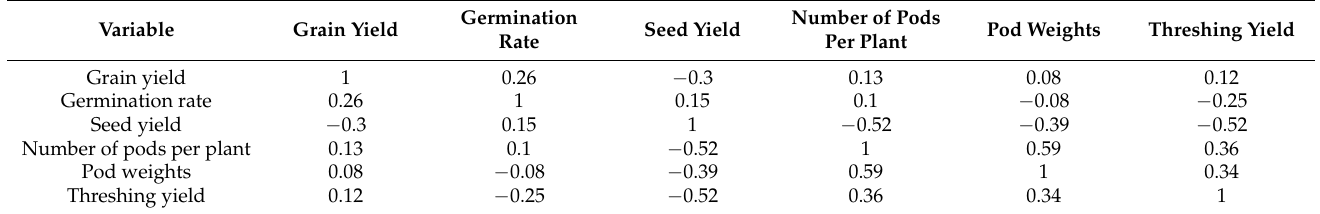
Figure 5. DCA quoted results for studied parameters between treated (red squares) and untreated (green diamonds) plant with insecticide. First axis explained 27.29% of variance and the second axis explained 23.40% of all the total variance. Table 4. Correlation for the most important parameters subjected by